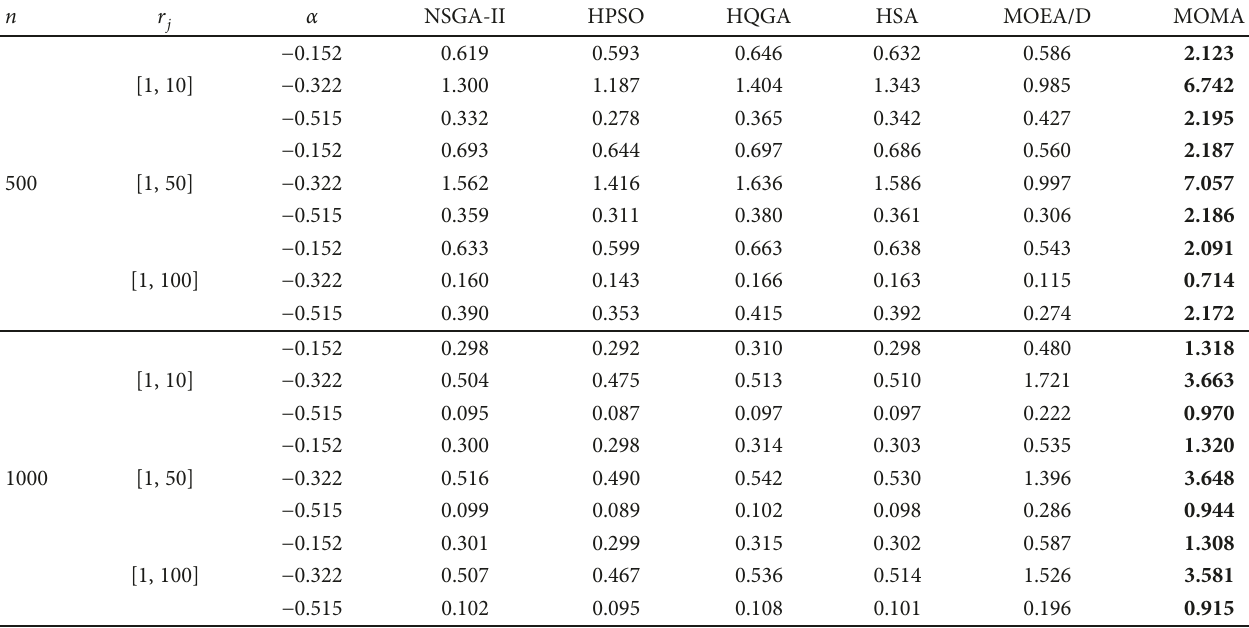
Table 5: The mean HV values ( × 10 10 ) of 6